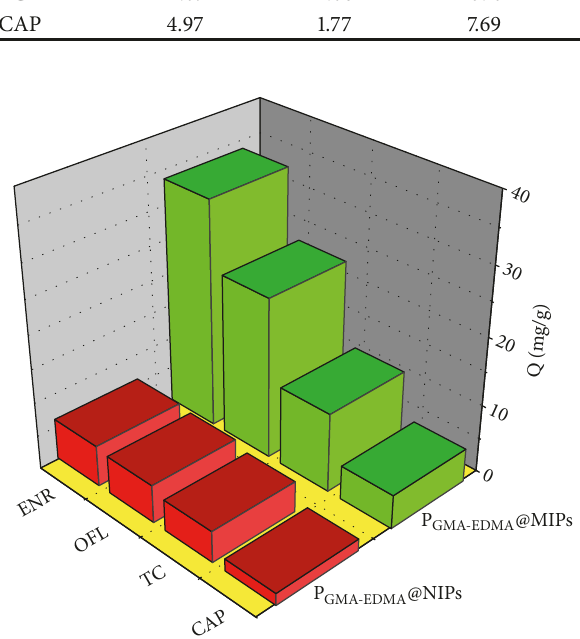
Figure 8: Binding isotherms of ENR, OFL, TC, and CAP on the P GMA @MIPs and P GMA @NIPs. - EDMA - EDMA